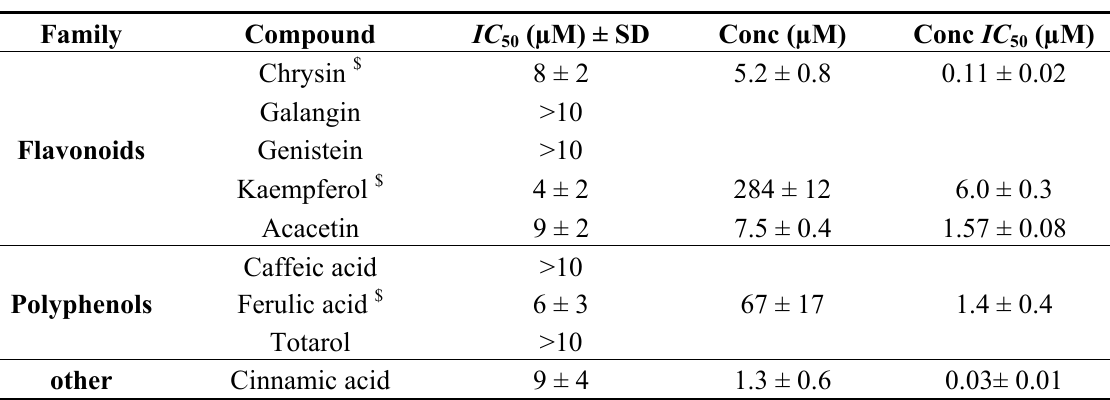
Table 4. IC values of the pure compounds found in the most active fractions for MPO 50 compared to their concentration in the ethyl acetate extract 1 (Tigzirt, 1.0 mg of extract/mL of water) and their concentrations extrapolated at the IC extract 1 (Tigzirt, 21 µg/mL).